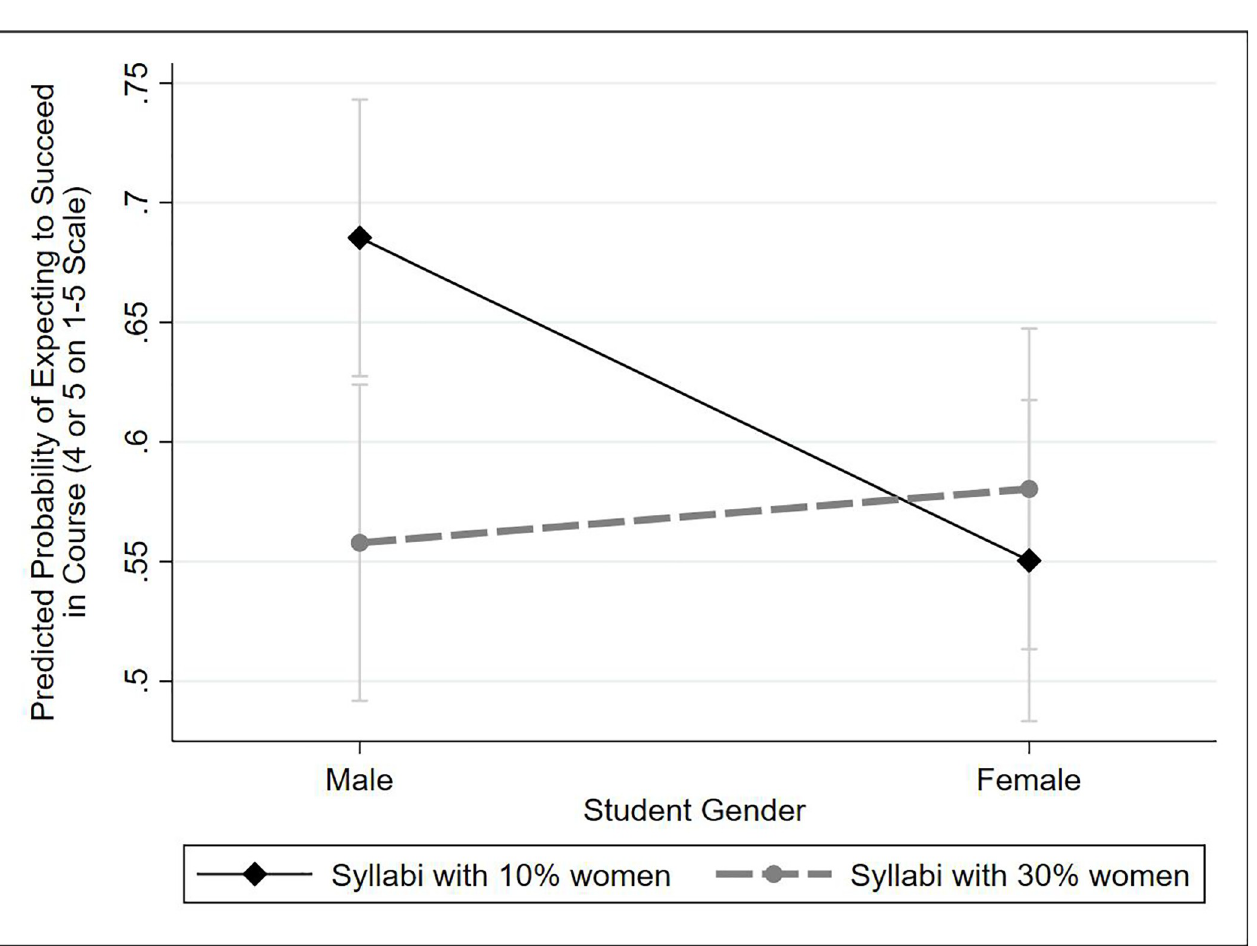
Fig 1. Impact of a gender-diverse syllabus on self-efficacy, by students’ gender. Results are from a logistic regression model predicting perceived likelihood of success in the course (coded as reporting a 4 or a 5 on a 1–5 scale), controlling for gender as well as orientations toward quantitative and qualitative methods, which are correlated with both gender and course-related self-efficacy (see S1 File for further discussion). The figure shows 76% confidence intervals; visual comparison of two 76% CIs is equivalent to a single 90% test [64,